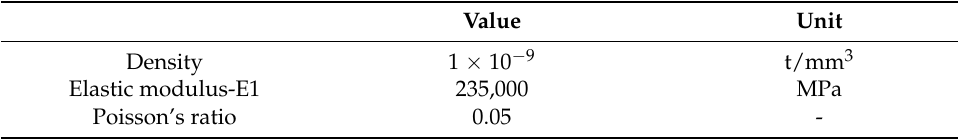
Table 5. The properties of CFRP in the numerical model.